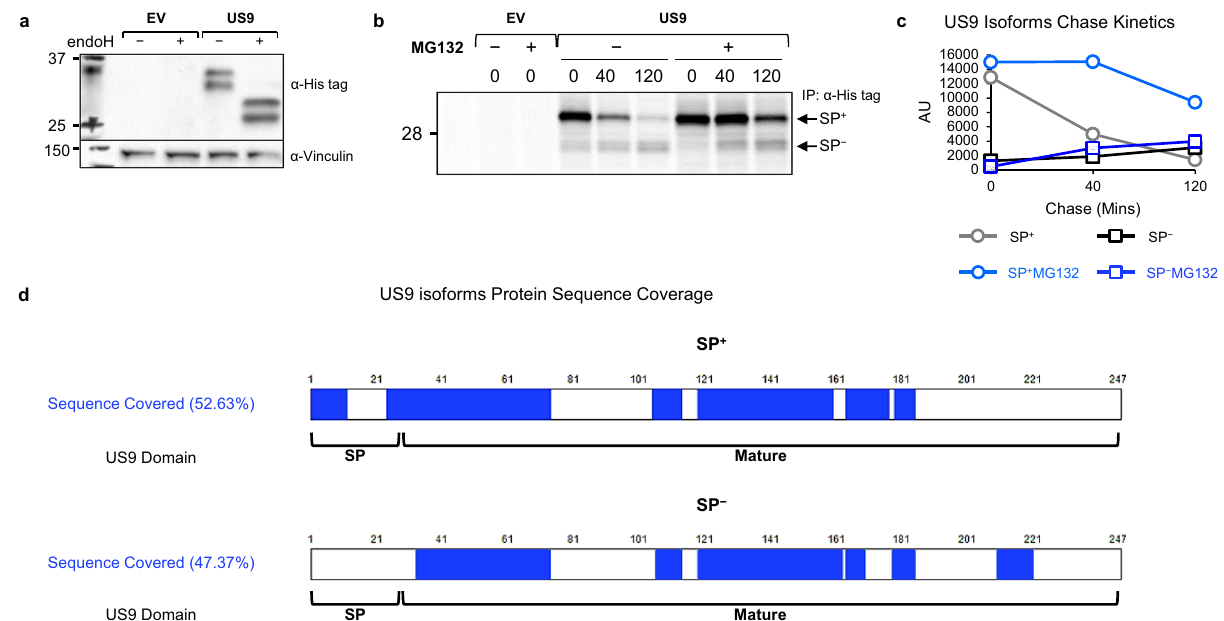
Fig. 1 US9 contains a slowly cleaved SP. a RKO MICA*008-HA cells co-expressing an empty vector (EV) or US9 attached to a C-terminal 6XHis tag were lysed. Lysates were mock-treated ( − ) or digested with endoglycosidase H (endoH; + ) and then blotted. Anti-His tag was used to visualize protein expression, with anti-vinculin as loading control. Representative of at least three independent experiments. b RKO MICA*008-HA cells expressing EV or US9 were radioactively labeled for 20 min (pulse) and then chased in the absence ( − ) or presence ( + ) of 10 µ M MG132. Digitonin-lysates were prepared at the indicated chase times (in minutes). An anti-His tag immunoprecipitation was performed. All samples were digested with endoH. Representative of three independent experiments. Ladder was visualized at a higher contrast, shown in Fig. S1b. c Quanti fi cation of the US9 isoforms shown in ( b ). AU arbitrary units. d Graphic representation of US9 protein sequence coverage detected by mass spectrometry analysis of the two US9 isoforms: SP + and SP −